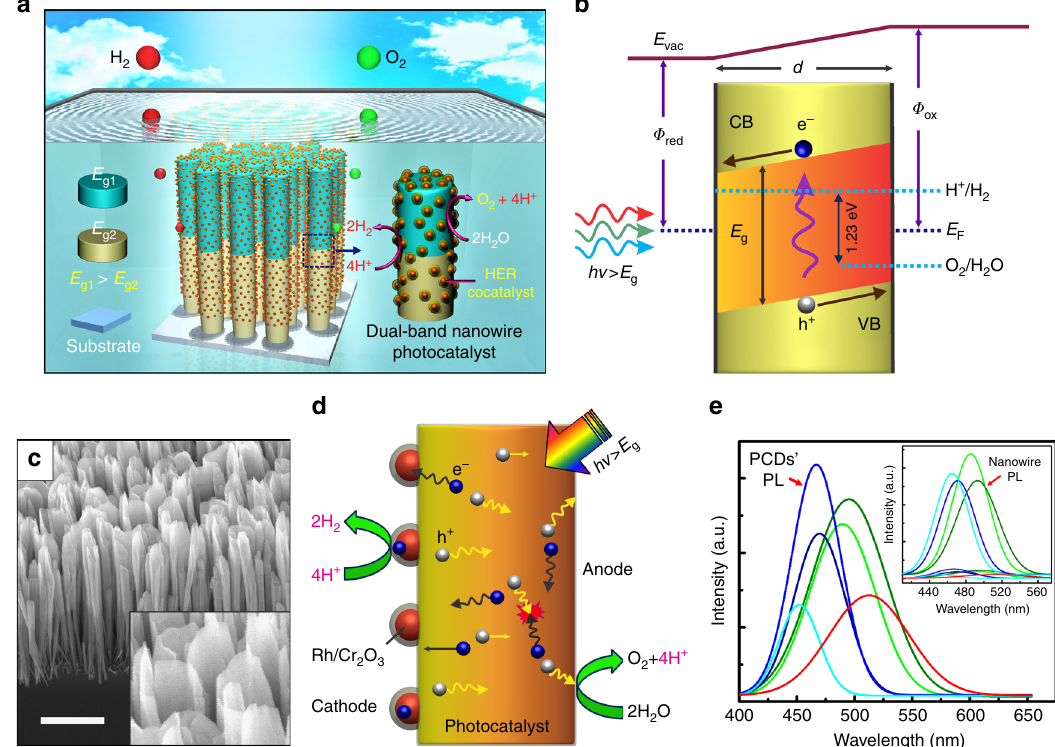
Fig. 1 Structural and optical properties of InGaN photochemical diode. a Schematic illustration of wafer-level unassisted photocatalytic overall water splitting on double-band nanowire arrays 36 , which are vertically aligned on a planar substrate and decorated with co-catalysts for hydrogen evolution reaction (HER). Unlike tandem PEC cells or photovoltaic (PV) devices 66 – 69 this approach does not require any carrier recombination/transfer or current matching between the layers along vertical direction. Both water oxidation and proton reduction reaction occur on the radial non-polar surfaces of each layer. b Energy-band representation of the proposed photochemical diode (PCD) with radial thicknes “ d ” showing the built-in electric fi eld (band-bending) that separates the charge carriers (electron and hole) and drives towards the opposite cathode and anode surfaces. In contrast to conventional p-n PCD (Supplementary Fig. 1 and Supplementary Note 1), only single photon absorption is required to generate one active electron – hole pair to participate in redox reaction (like Schottky-type photochemical diode). c A 45° tilted SEM image of InGaN:Mg PCD nanostructures, vertically aligned on Si substrate. Scale bar, 1 µ m. The magni fi ed image of the nanosheets is also presented in the inset for clarity. d Schematic (real space) depiction of the dynamic behaviors of charge carriers in a single-photon PCD upon photoexcitation. Electron enriched surface (cathode) of the PCD is largely decorated with photo-deposited HER co-catalysts (Rh/Cr 2 O 3 core/shell nanoparticles). e Room temperature photoluminescence (PL) spectrum from as-grown p-InGaN PCDs for different indium incorporations (correspond to different bandgaps, depicted using distinct colors). The inset shows ~20-fold reduction in PL intensity for the photochemical diodes compared to that of